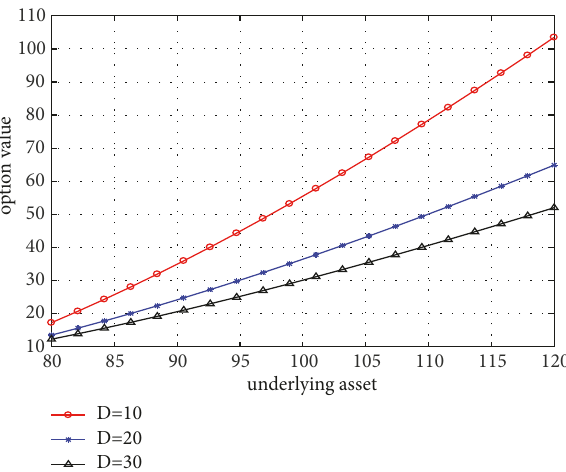
Figure 2: Change of option value under different pricing methods.